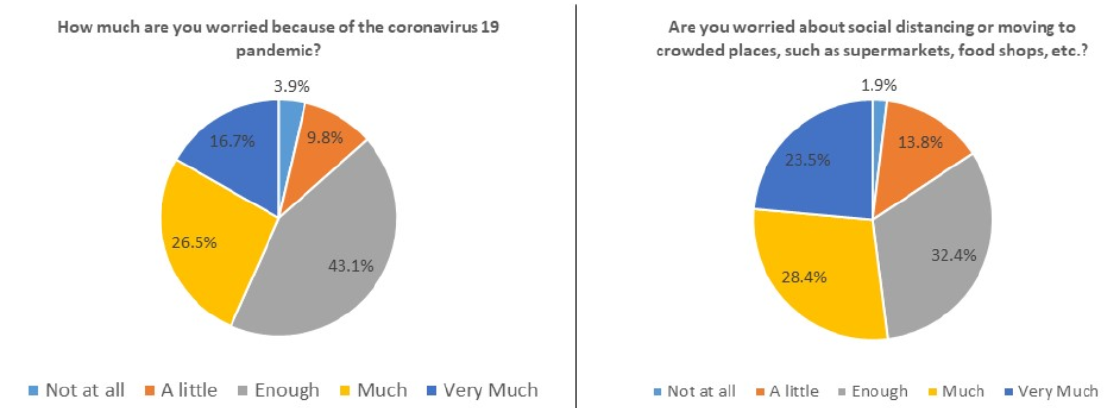
Figure 2. Perception of COVID-19 infection from patients with eosinophilic gastrointestinal diseases (EGIDs) in the Campania and Veneto regions of Italy.